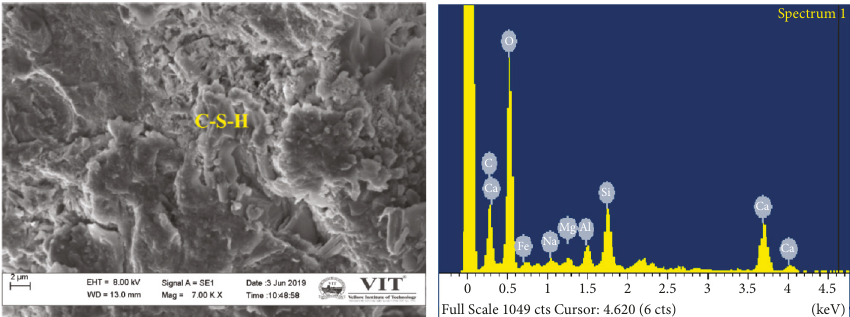
Figure 7: SEM image and EDX spectrum of mix OPC (C100R100). X: unreacted or partially reacted GGBS particles. Y: unreacted or partially reacted fly ash particles. Z: geopolymer gel.